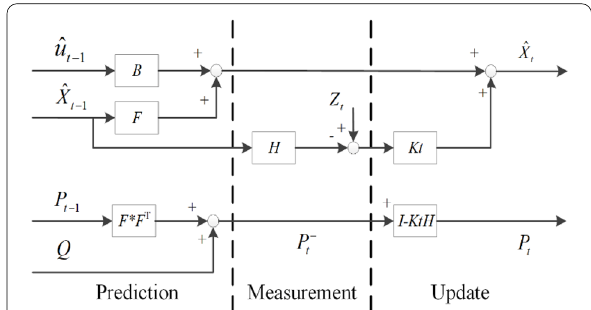
Figure 10 The Kalman filtering process